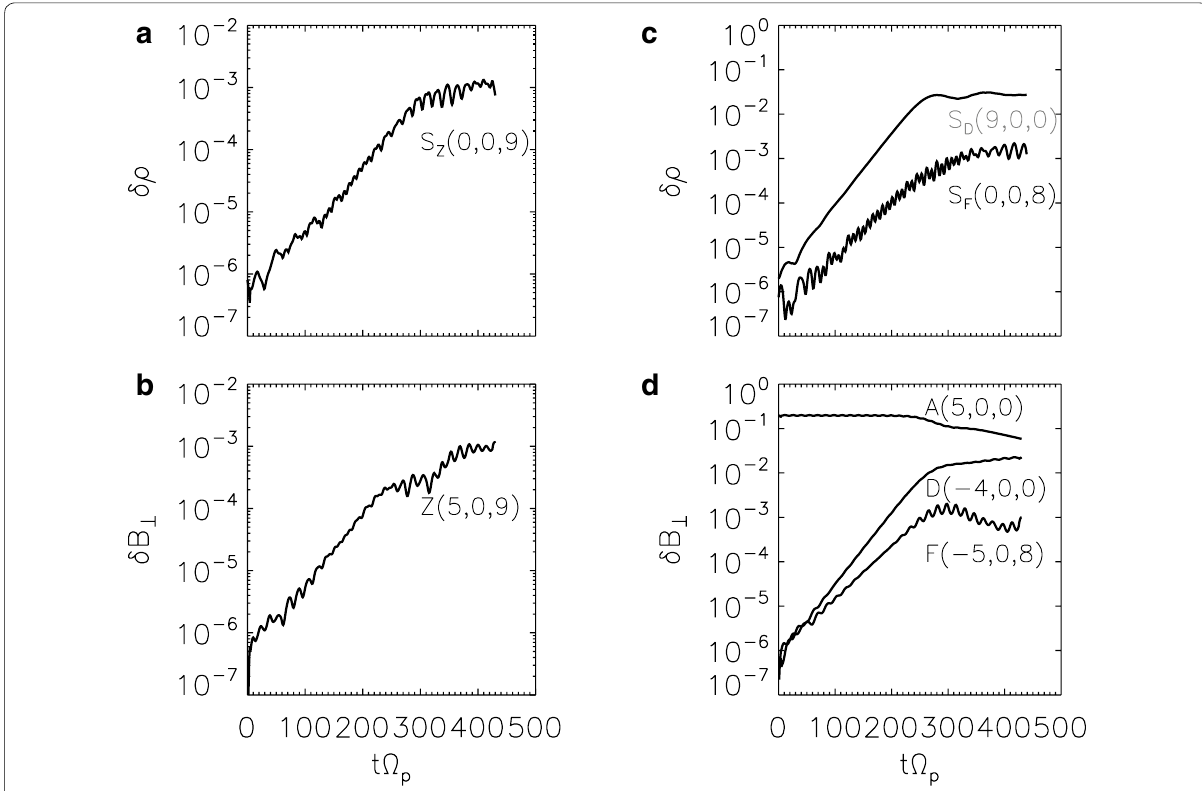
Fig. 4 Time evolution of the density and magnetic field fluctuations: longitudinal daughter mode S Z ( 0,0,9 ) and Alfvén sideband Z (5, 0, 9) are shown in a and b , and the longitudinal daughter mode S F ( 0,0,8 ) and Alfvén sideband F ( − 5,0,8 ) in c and d . For comparison, the Alfvén pump wave A (5, 0, 0) and the dominant daughter modes S D ( 9,0,0 ) and D ( − 4,0,0 ) provided by the field-aligned decay instability are also